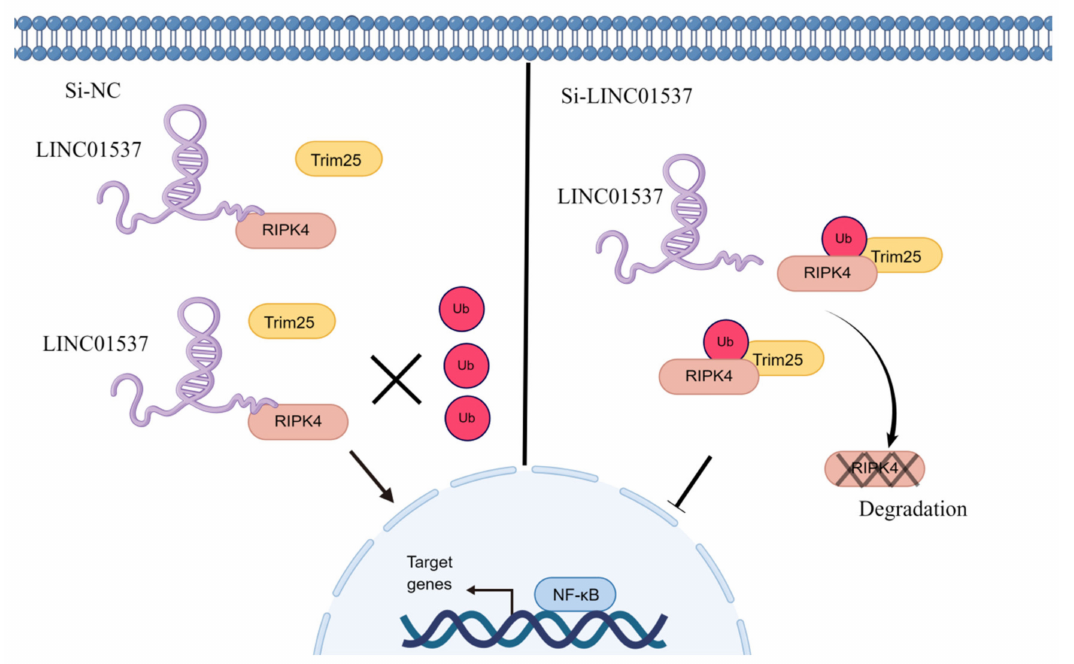
Figure 8. A graphical illustration of LINC01537 activating NF- κ B-p65 by stabilizing RIPK4 and reducing its ubiquitination